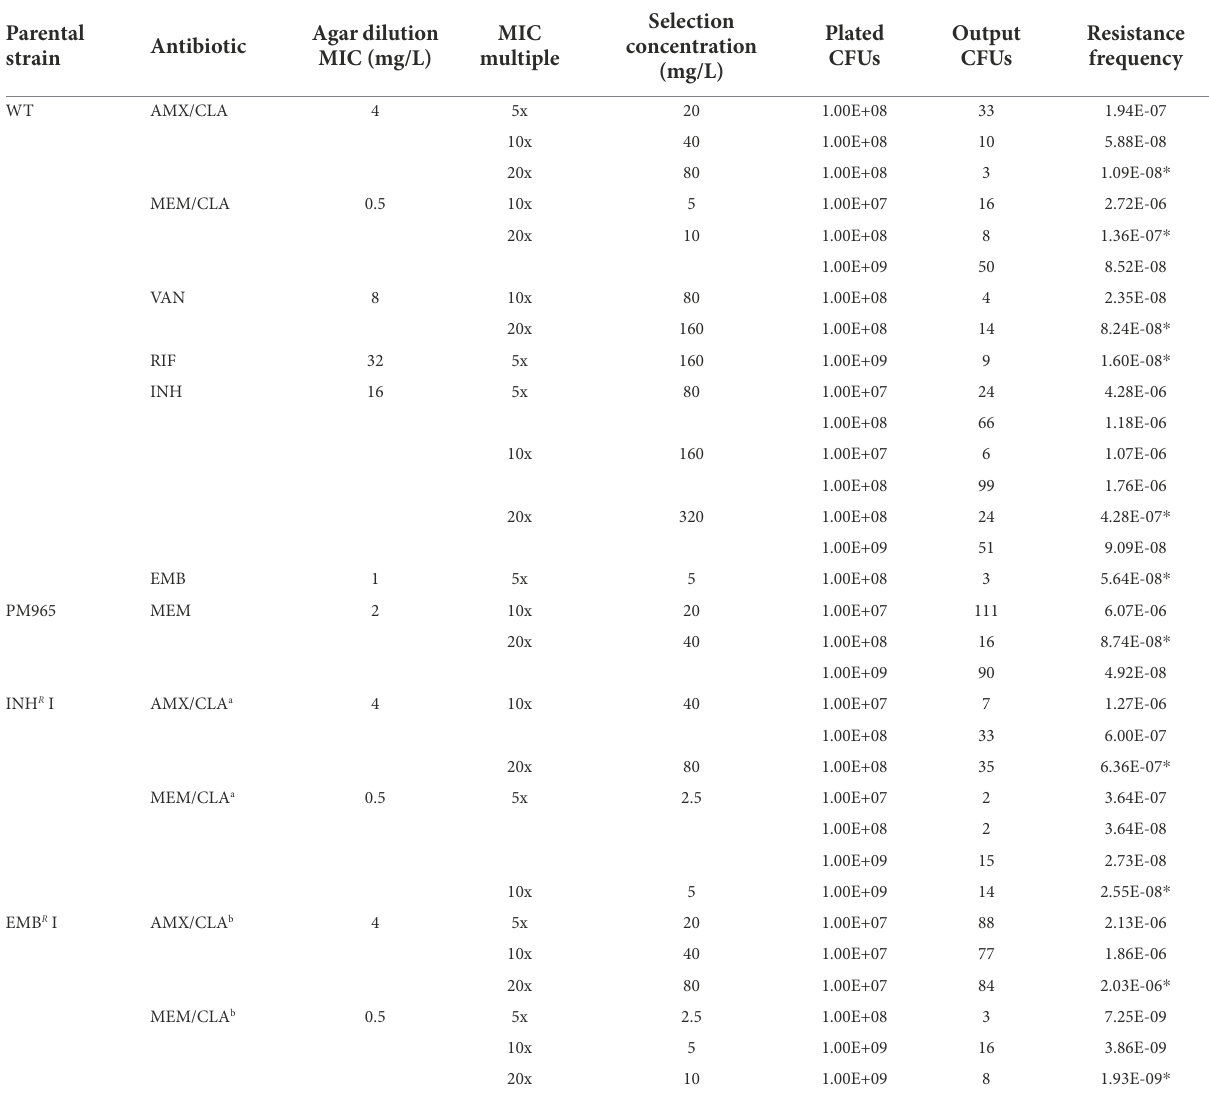
TABLE 1 Selection conditions and resistance frequency at which Msm isolates were retrieved. Parental